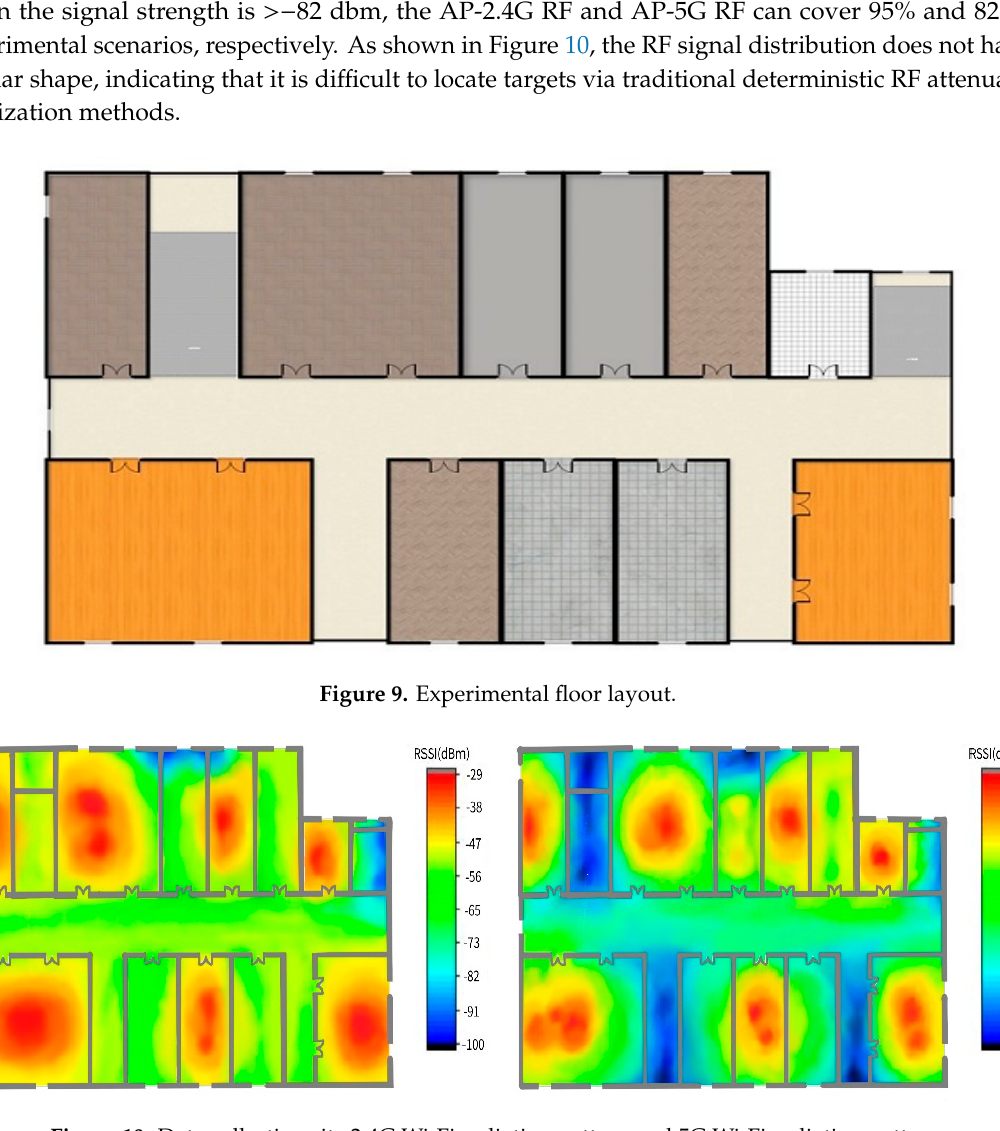
Figure 10. Data collection site 2.4G Wi-Fi radiation pattern and 5G Wi-Fi radiation pattern.